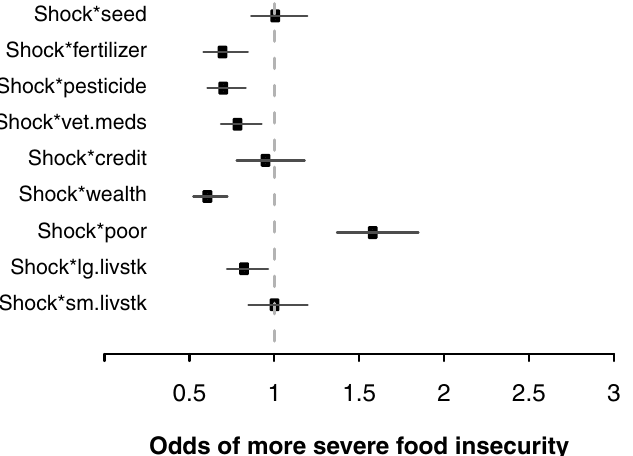
Fig 3. Effects of factors predicting household food insecurity among climate shocked households. Plotted estimates represent the marginal effect on food insecurity associated with particular household-level predictors (95% CI), as compared to a hypothetical household that does not exhibit that predictor yet also experiences shock and is otherwise similar in regards to all other model variables. Plotted estimates are the additive results of corresponding direct (Fig 2) and interaction effects (Table 1 in S1 File). The model includes varying intercept effects for site and region (Figure A in S1 File), which are not displayed.